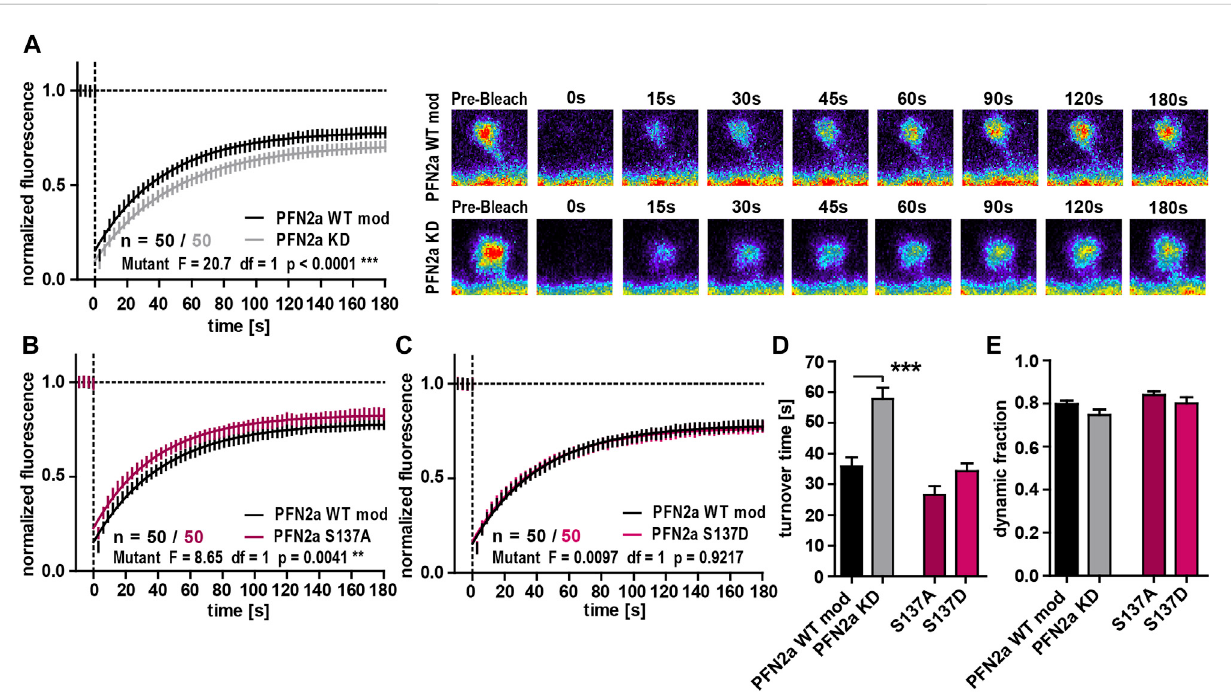
FIGURE 2 PFN2a regulates basal spine actin dynamics. (A) Fluorescence Recovery After Photobleaching (FRAP) experiments of EGFP-ß-actin analyzing basal actin dynamics inhippocampal neurons after 23 days inculture.Depicted are the recovery curves over a time course of 180s after the bleaching pulse of dendritic spines from hippocampal neurons where endogenous PFN2a was knocked down and replaced with WT PFN2a (PFN2a WT mod) or mApple (PFN2a KD). n = 50 spines each. N = 3 experiments. Representative images show fl uorescence levels derived from EGFP-ß-actin of an individual dendritic spine before bleaching as well as during recovery of fl uorescence over a time course of 180s after the bleaching pulse. Note that the data depicted in (A) is based on the same data already shown in Figure 1B. (B, C) FRAP experiments comparing basal actin dynamics in dendritic spines